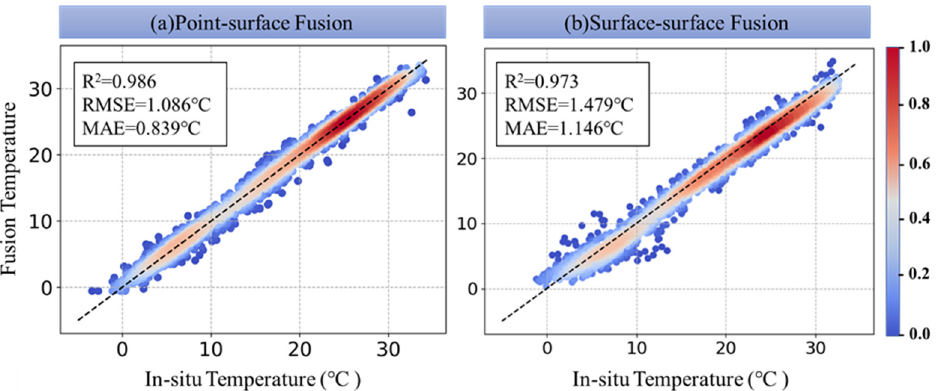
Figure 14. The density scatter plots for 32 validation stations based on point–surface data fusion ( a ) and surface–surface data fusion ( b ). The x and y axes represent in-situ ground measurements and fusion temperature, respectively. The red color represents dense concentration of scatters.